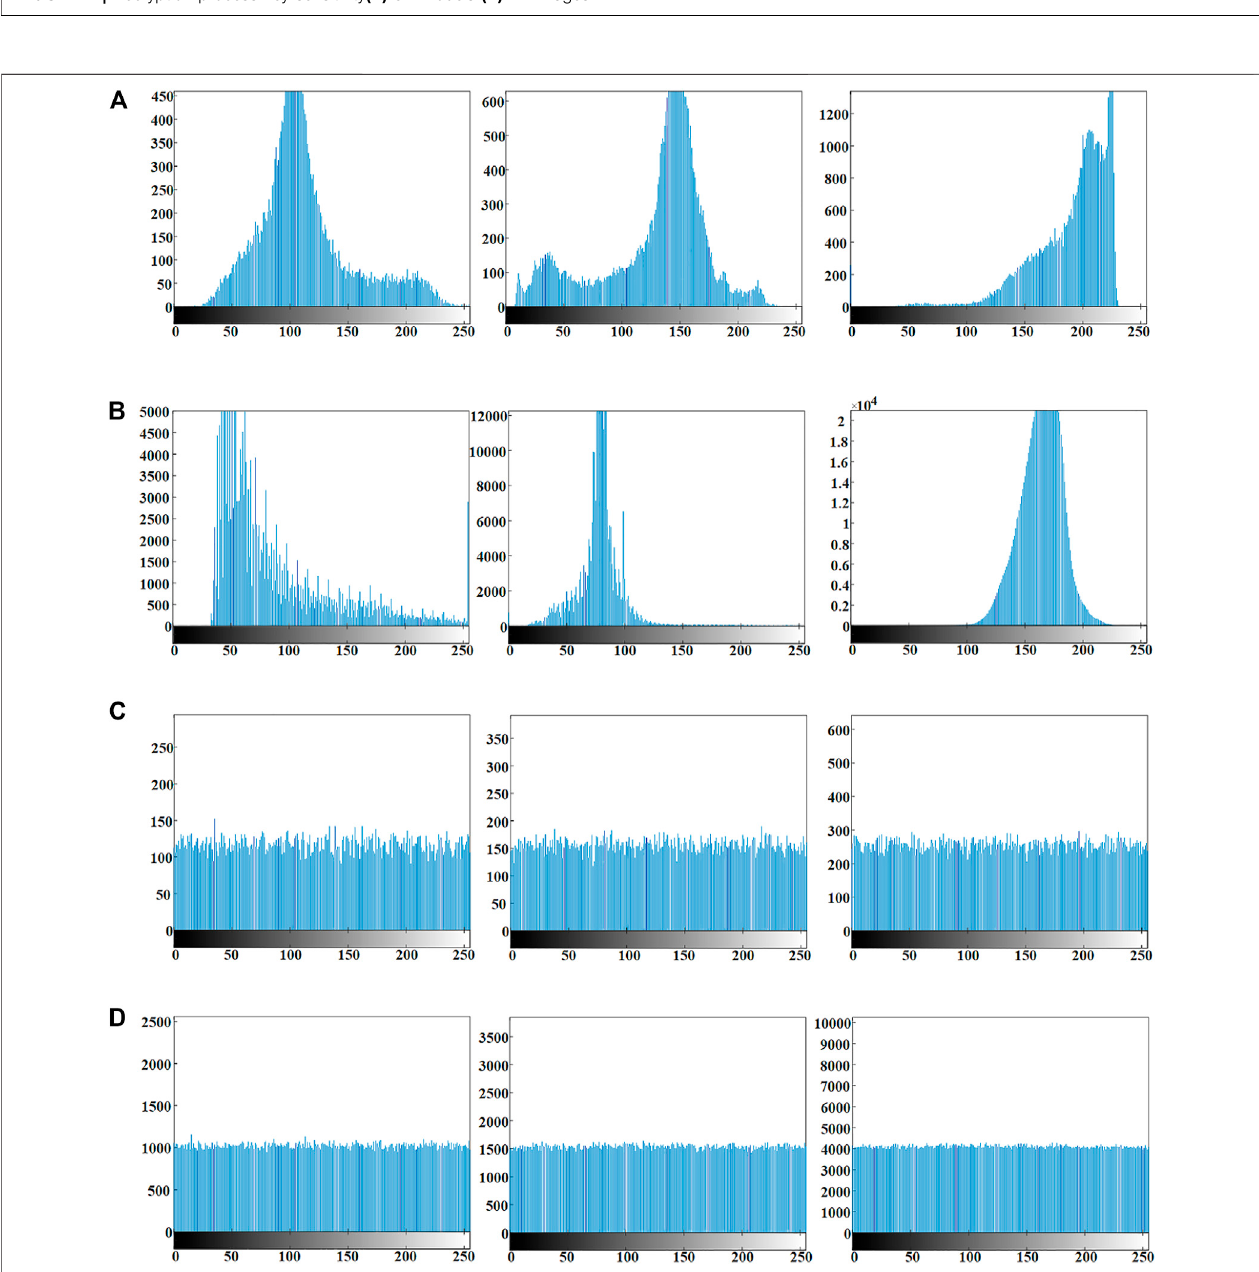
FIGURE 8 | Histogram of encryption and decryption images (A,B) Histogram of plain images (Water, Boat, 5.1.11, Crowd, Kodimo2, 2.2.11) (C,D) Histogram of cipher images.